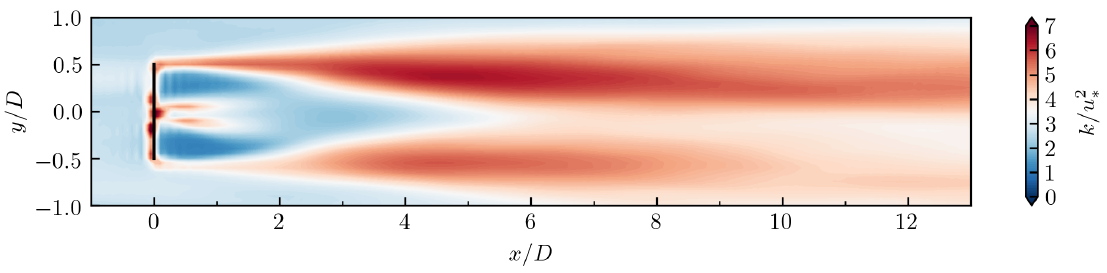
Figure 18. The averaged TKE in the horizontal plane at the hub